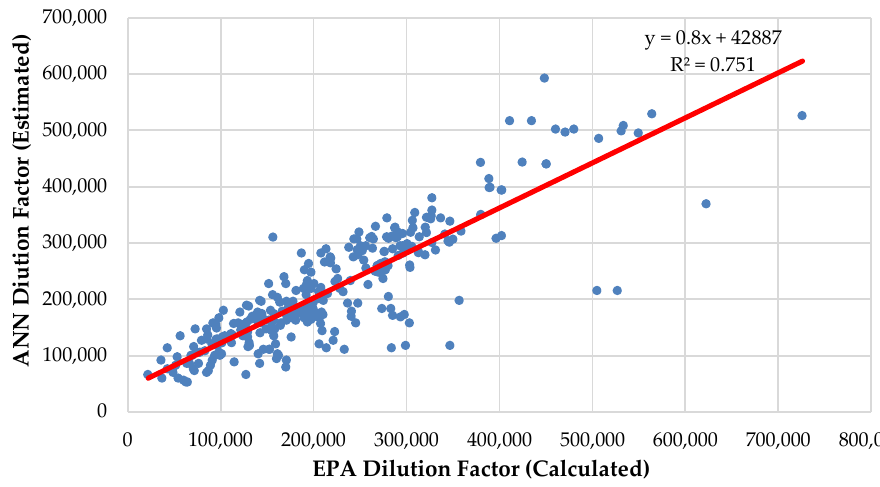
Figure 6. Calculated and estimated dilution factor for only gross ton inputs ( DF ANN = f ( GT )) .